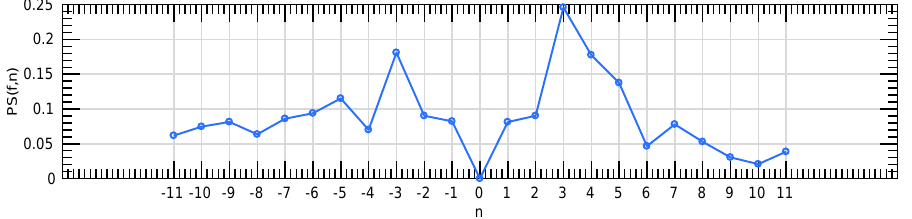
Figure 8. A global pattern spectrum extracted by the combination of the granulometric and anti- granulometric